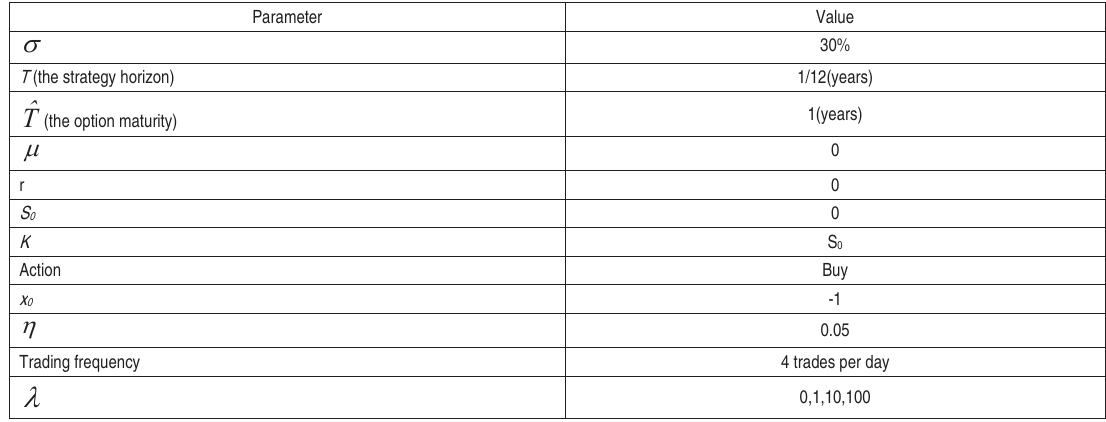
Table 3. Simulations inputs